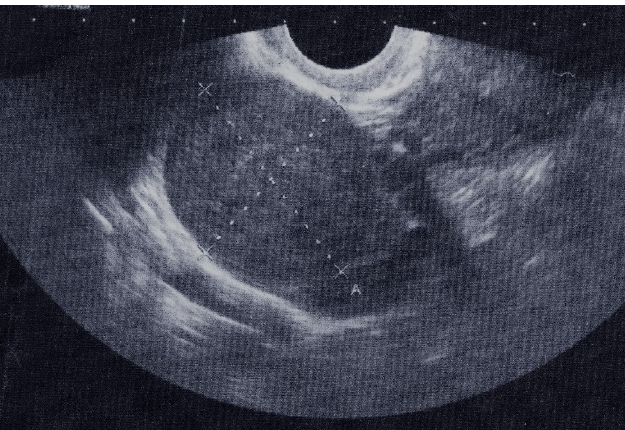
Figure 1. Transrectal sonography (TRS): solid tumor formation, 41.2 mm (A-X) × 29.5 mm (X-X) in diameter, with normal ovarian tissue on the periphery.